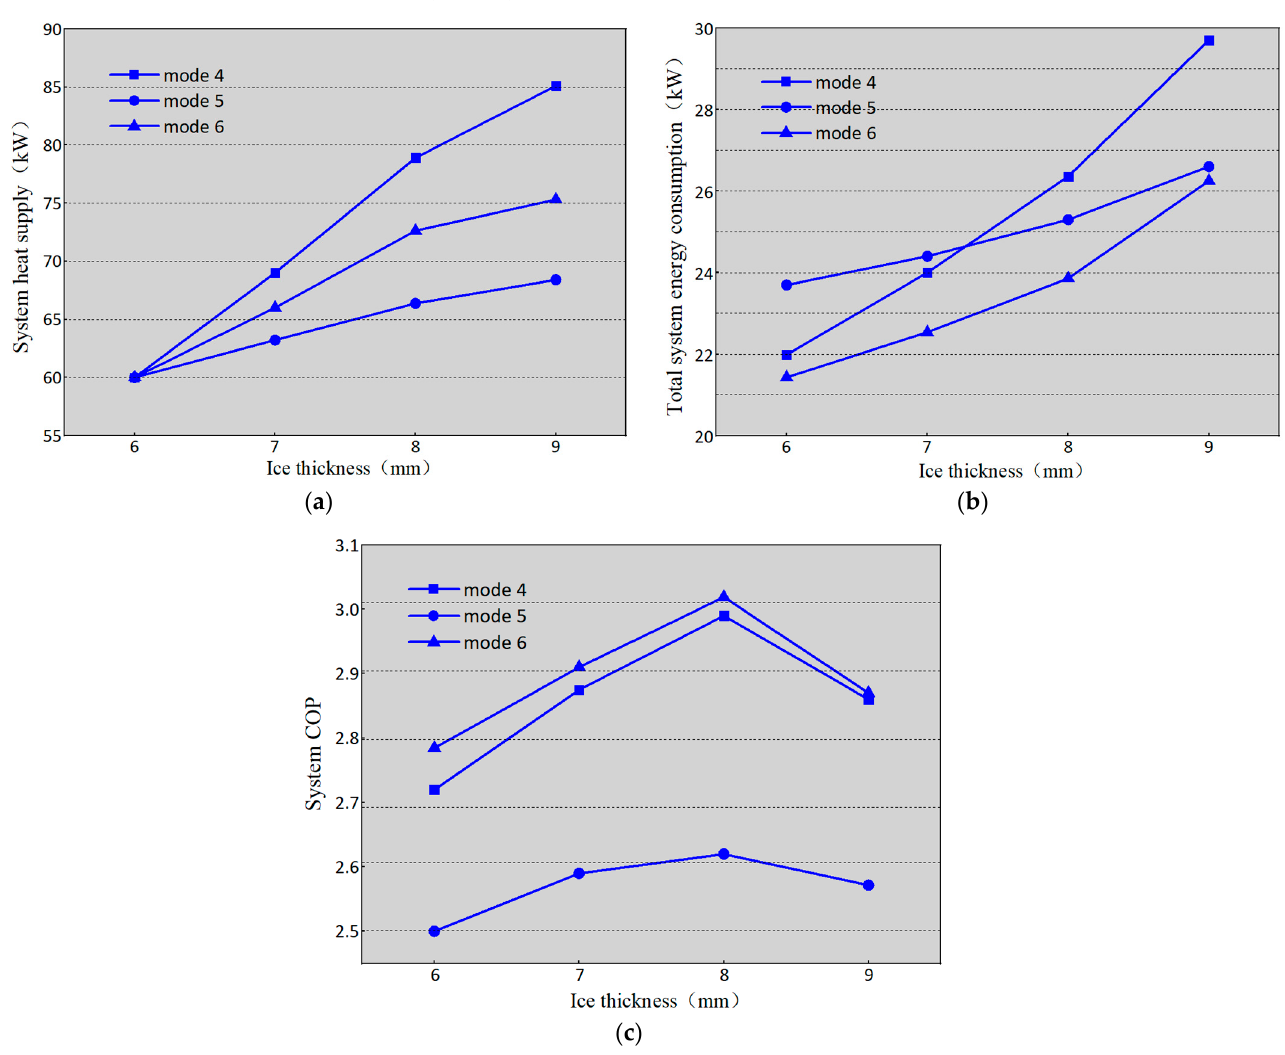
Figure 8. ( a ) The effect of ice thickness on system heat supply; ( b ) the effect of ice thickness on system power consumption; ( c ) the effect of ice thickness on the system COP.